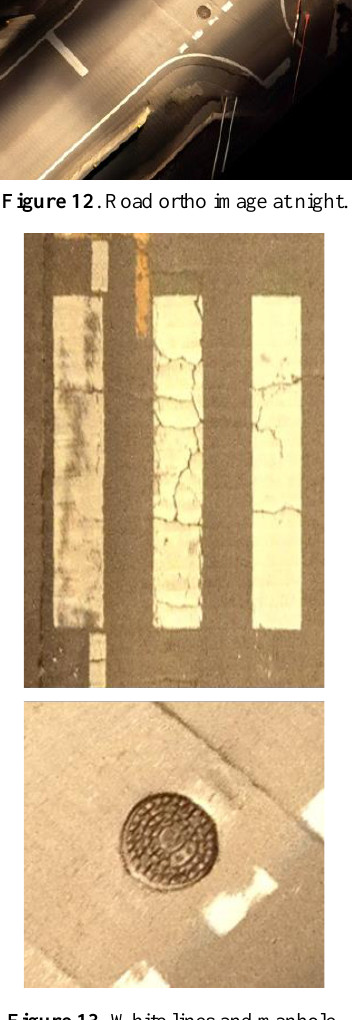
Figure 13 . White lines and